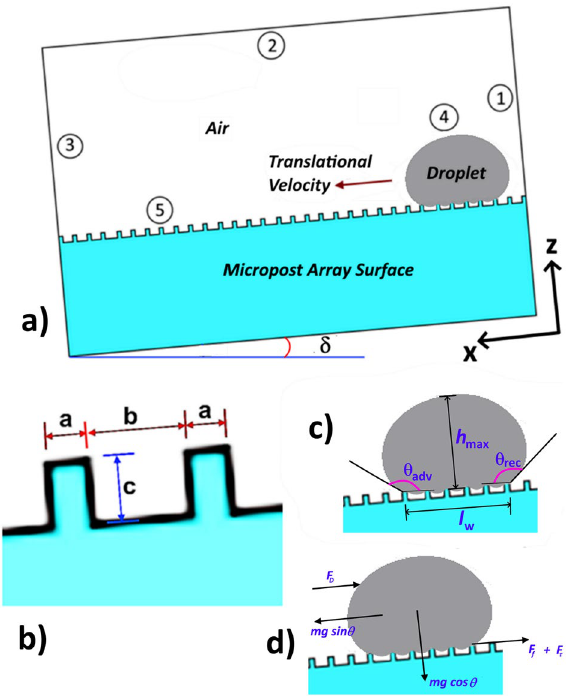
Figure 1. ( a ) Five boundary conditions are adopted for the rolling droplet down the micro-post array surface. ( b ) Geometrical representation of the micro-post array, ( c ) droplet geometrical dimensions, ( d ) forces acting on droplet geometry. The pressure outlet is defined at boundaries 1, 2, and 3. Boundary 4 resembles the interface between the droplet and surrounding, which is free to deform. Boundary 5 is the wetted wall at which the contact angle and adhesive forces are